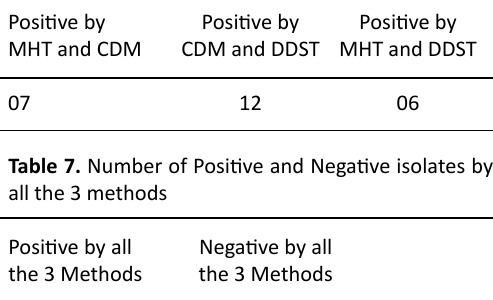
Table 5. Test Result of Carbapenemase and MBL detection by different Methods Name of Total number Number of Number of